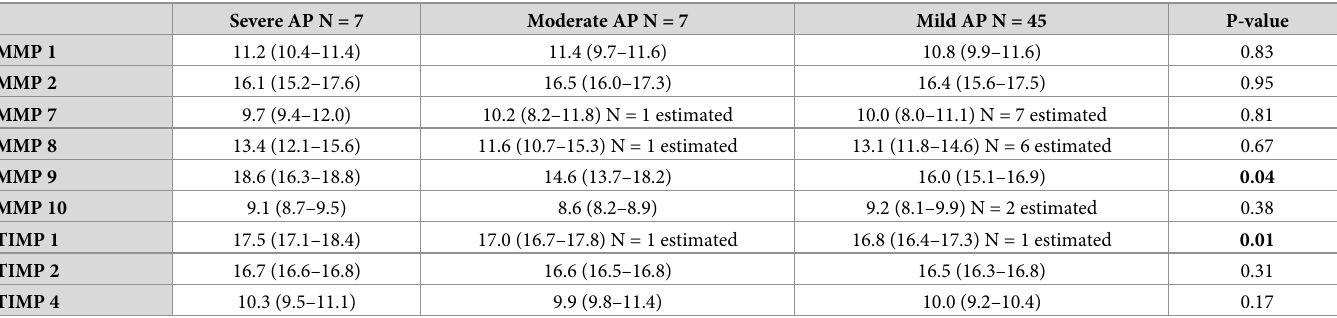
Table 3. MMPs and TIMPs: Severe vs moderately severe vs mild AP.